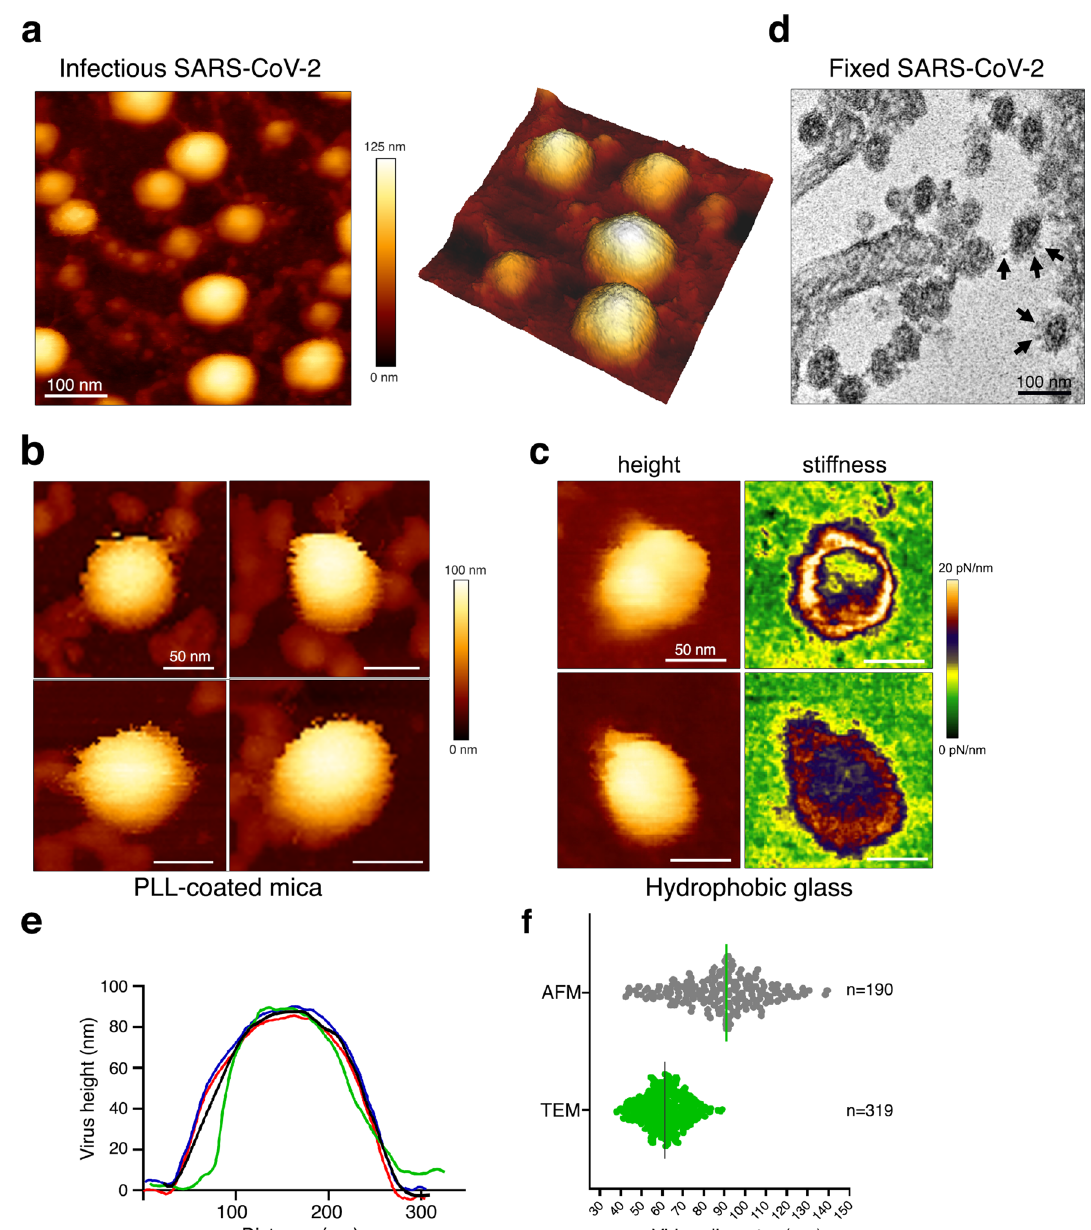
Figure 1. Native infectious SARS-CoV-2 virions imaged by AFM (a) Topographic image and 3D projection of native infectious SARS-CoV-2 virions adsorbed on a poly-l-lysine (PLL)-coated mica surface using quantitative imaging (QI) mode AFM in buffer. ( b,c ) Zoom-in view of SARS-CoV-2 virions adsorbed on poly-l-lysine- coated mica ( b ) or glass coverslips coated with an alkyl silane ( c ) (scale bars: 50 nm). In ( c ) height and stiffness images acquired in QI mode on individual virions are shown. ( d ) Example of a TEM image of fixed infected VeroE6 cells producing SARS-CoV-2 that can be seen as spherical particles studded with S trimers (see arrows). ( e ) Examples of topographical profile plots measured along the horizontal diameter of viral particles. ( f ) Virion diameter distribution of infectious SARS-CoV2 samples imaged by AFM in liquid (height profile, n = 190 objects) and compared to fixed samples imaged by TEM (n = 319